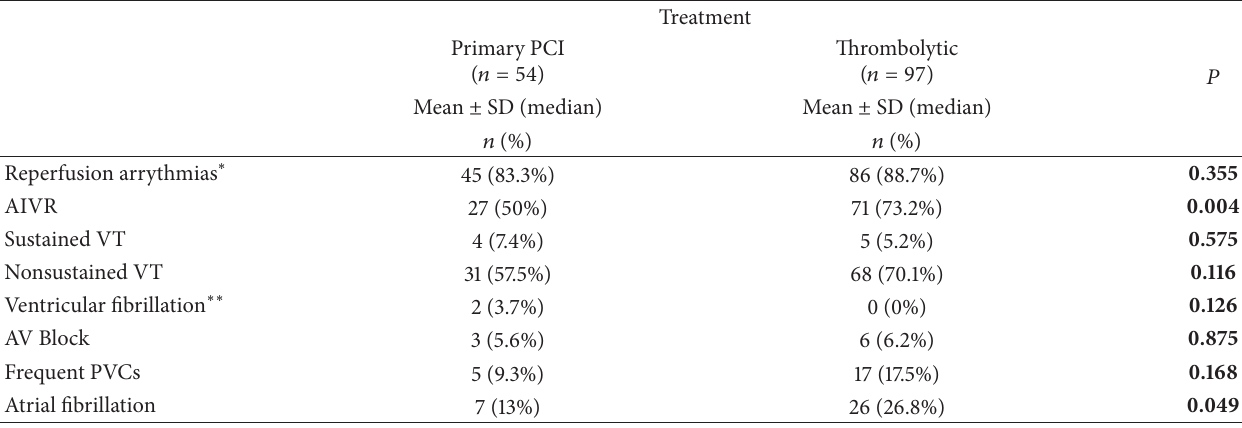
Table 3: Comparison of the frequency of various reperfusion arrythmias between primary percutaneous coronary intervention and thrombolytic treatment groups of patients.